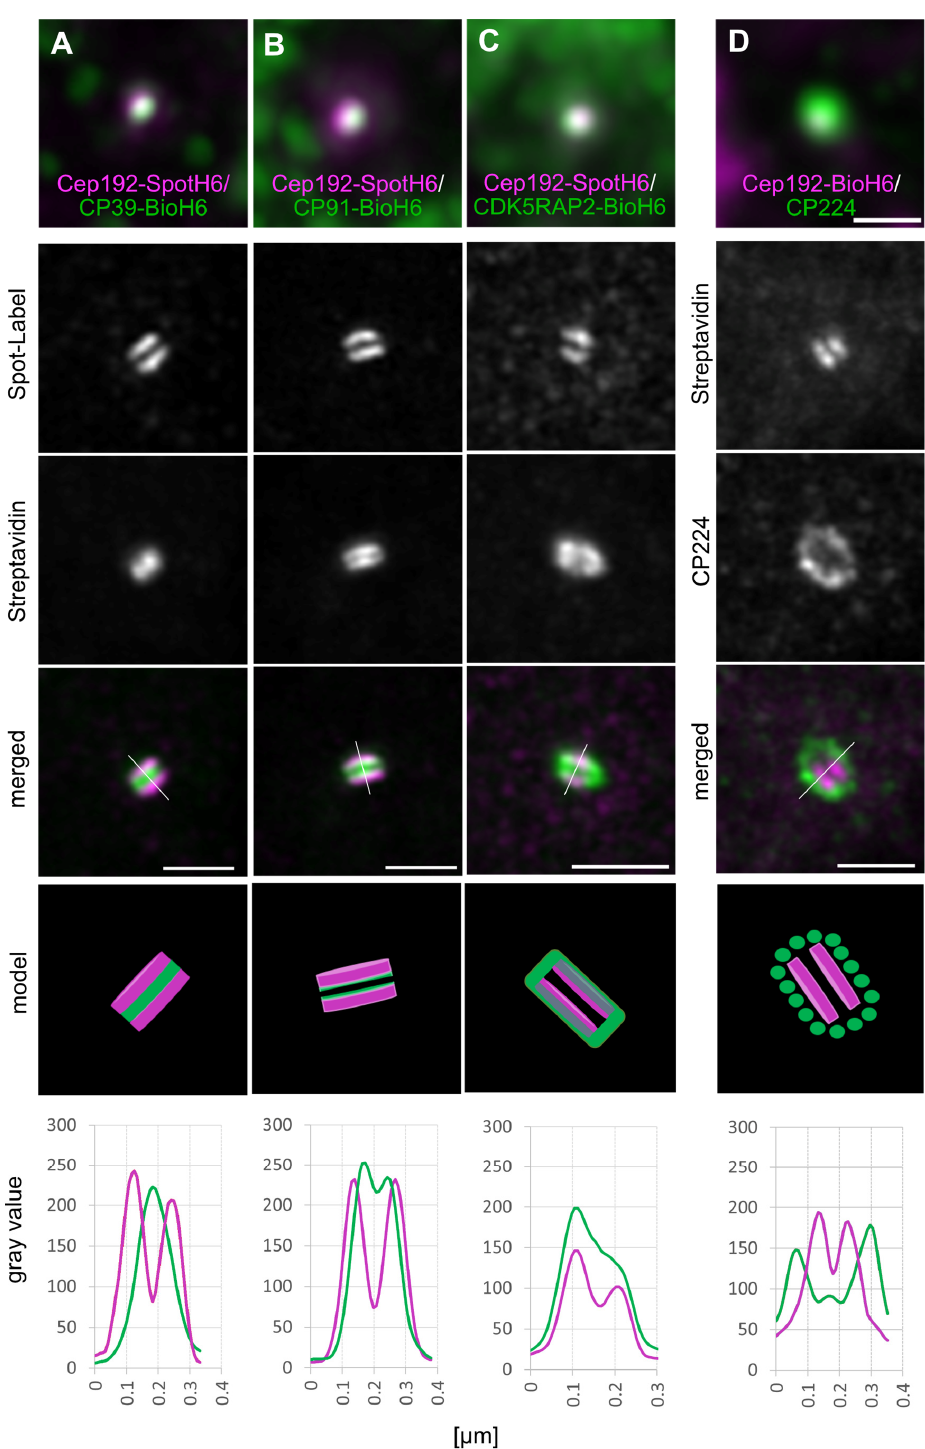
Figure 3. Subcentrosomal distribution of CP39-BioH6 ( A ), CP91-BioH6 ( B ), CDK5RAP2-BioH6 ( C ), and CP224 ( D ) relative to Cep192-SpotH6 ( A – C ) and Cep192-BioH6 ( D ). First row represents merged images of unexpanded specimen, gray scale images and corresponding merged images are expanded specimen, resulting in the localization models and intensity distribution graphs along the drawn lines in the merged images. Cells were fixed with methanol and stained with anti-Spot- Atto-594 nanobody ( A – C ), Streptavidin-AlexaFluor-488 ( A – D ), and anti-CP224/anti-mouse-568 ( D ). Shown are maximum intensity projections of Airyscan processed (expanded) or deconvolved images (non-expanded). Scale bar = 500 nm, for the expanded specimen the scale was fitted using the expansion factor to represent the original size of the